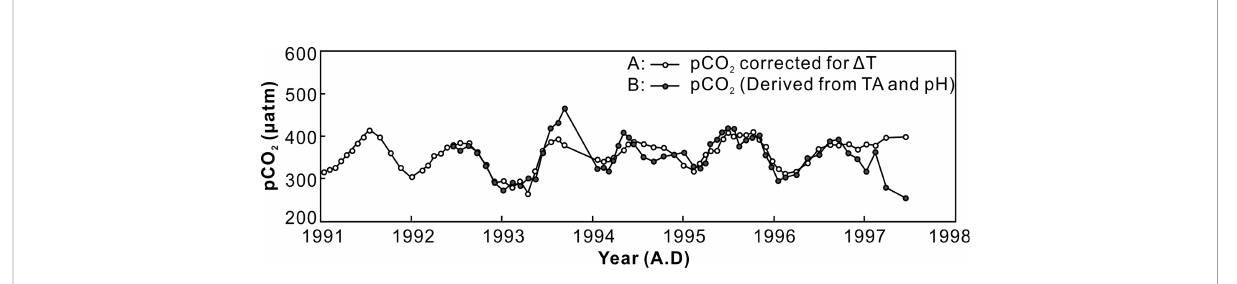
FIGURE 7 The correlation of reconstructed pCO 2 records derived from SST (A) and TA (B) in Lanyu Island using the CO 2 sys.xls program of Pelletier et al. (2005). The seasonal variation in seawater pCO 2 can also be observed, with higher pCO 2 in warm seasons (higher SST) in this